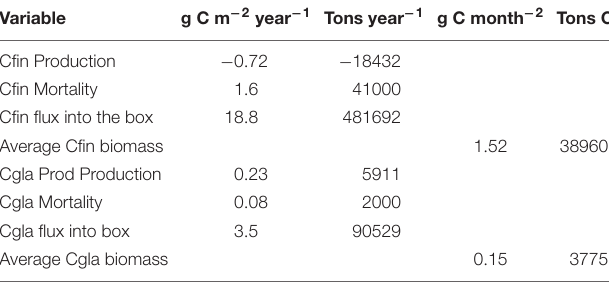
TABLE 1 | Production (growth-respiration), mortality, influx and average biomass of Calanus finmarchicus (Cfin) and Calanus glacialis (Cgla) in/into the box north of Svalbard (see Figure 3 ). The box area is 25,600 million month − 2